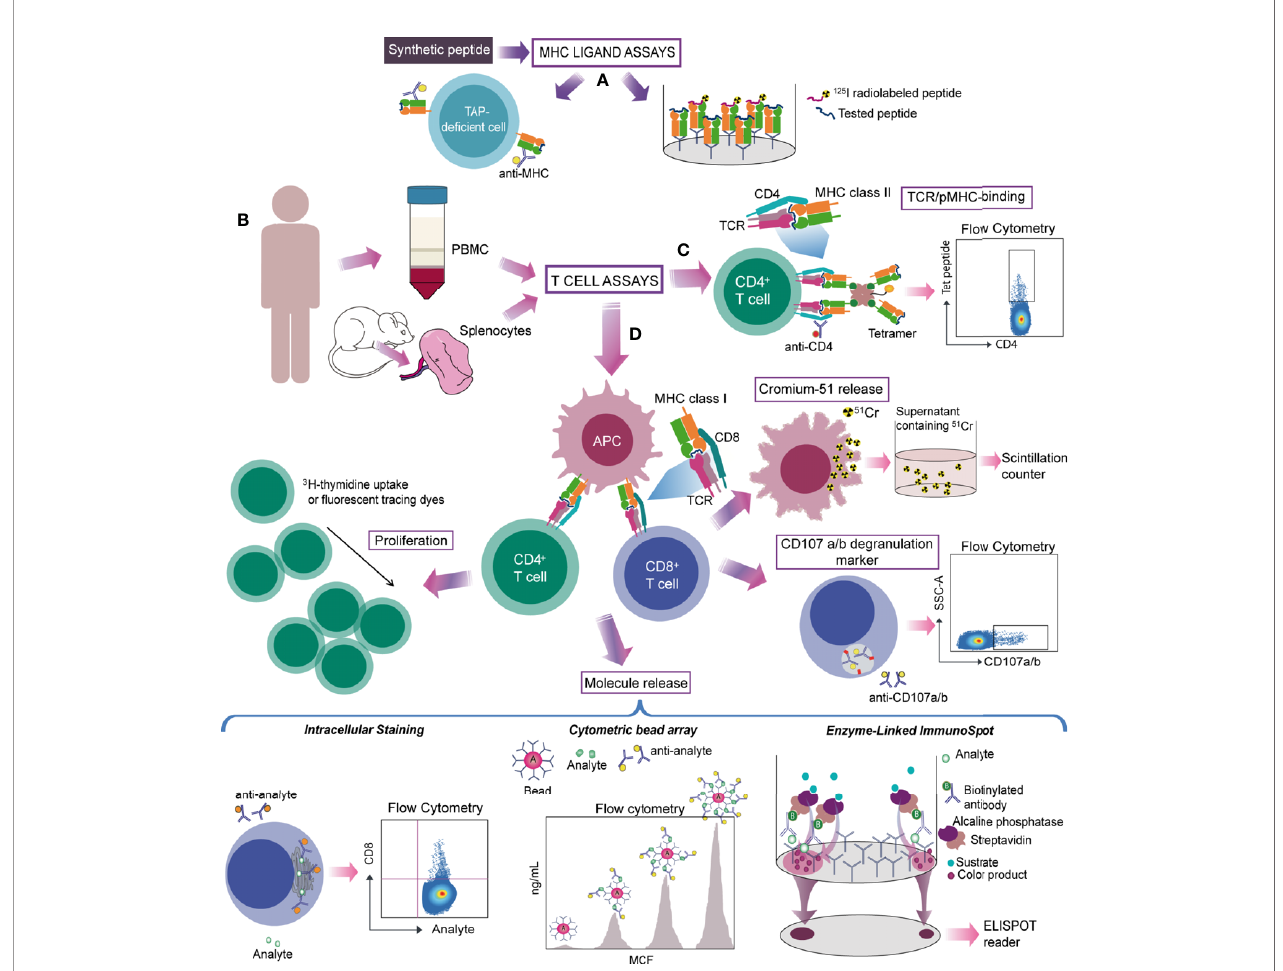
FIGURE 3 | Strategies for studying antigen-speci fi c T cells in Chagas disease. (A) Experimentally identi fi ed or predicted candidate target peptides are synthesized and tested by MHC ligand assays. MHC-peptide binding can be evaluated by TAP de fi cient cells (cells lacking the transporter associated with antigen-processing that fail to transport peptides into the endoplasmic reticulum, reducing MHC class I stability and surface expression) loaded with the peptide and stained for the MHC, or by the ability to inhibit the binding of a radiolabeled probe peptide. (B) Splenocytes from mouse, PBMC from human or CD4 + - or CD8 + -depleted PBMC are used to detect antigen-speci fi c T cells trough T cell assays. (C) MHC-peptide multimer/tetramer is based on the ability of TCR to recognize the pMHC complex from CD8 + or CD4 + T cells. (D) Other strategies evaluate the speci fi c T-cell response on the basis of a functional readout. Activated cytotoxic CD8 + T cells are commonly detected by measuring chromium in the supernatant released by killed target cells. Assays that determine secretion of cytolytic granule contents (granzyme or perforin) and/or labelling responding cells with antibodies to CD107a and b provide an alternative way to measure cytolytic activity. On CD4 + T cells activation, the ampli fi cation of antigen-speci fi c populations is tested through proliferation assays. Molecule release (cytokines or cytolytic granule contents) from activated CD8 + or CD4 + T cells can be evaluated by different methods. Intracellular staining of induced molecules detects speci fi c T-cells on a single cell level whereas CBA measures secreted proteins produced by bulk cell populations. ELISPOT detects secretion “ spots ” of a speci fi c mediator and quanti fi es the magnitude of this response. Monoclonal antibodies for phenotyping can be used to characterize speci fi c T